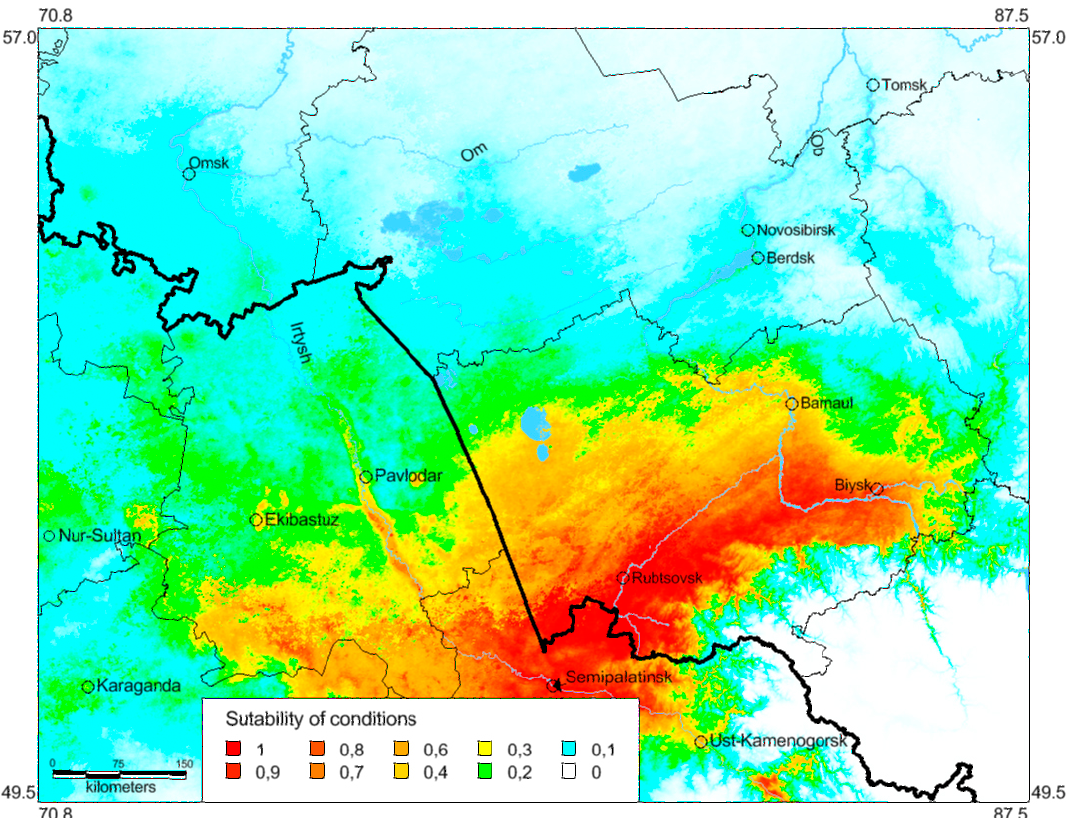
Figure 5. Predicted probabilities of suitable conditions for Oedaleus decorus in the south-eastern part of the West Siberian Plain (distribution data before 1961 and bioclimatic variables for 1970–2000; point-wise mean for 20 replicates).